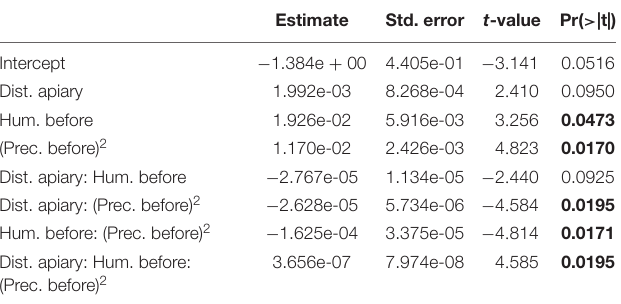
Genetic Variability The analysis of workers from honey bee colonies and drones from DCAs revealed the presence of four mitochondrial haplotypes ( Figure 6 ). Two haplotypes corresponded to evolutionary branch A (A1, A4), and two haplotypes corresponded to branch C (C1 and C2J). The African haplotypes A1 and A4 have been observed at a high frequency in African subspecies A. mellifera intermissa and A. m. scutellata , respectively, while the